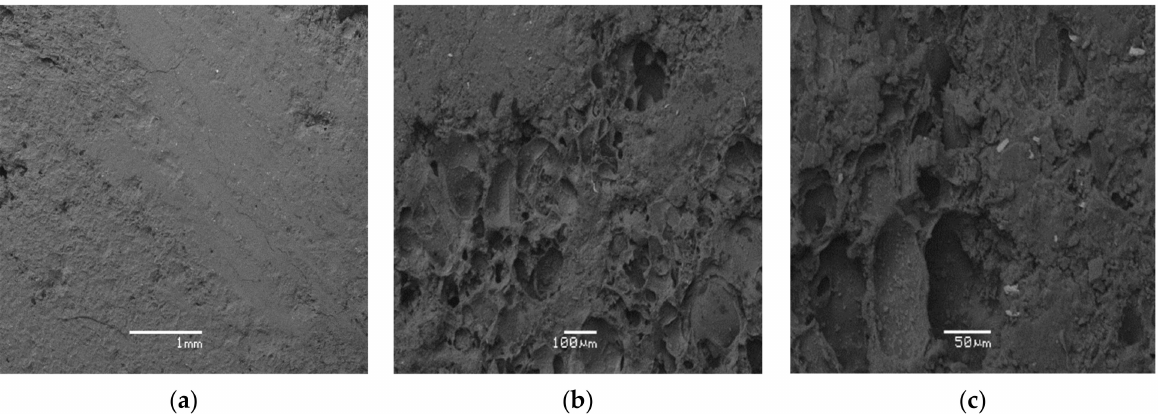
Figure 6. SEM photos of Pu concrete samples: ( a ) ITZ area, ( b ) and ( c ) aggregate pore filled by cement paste.